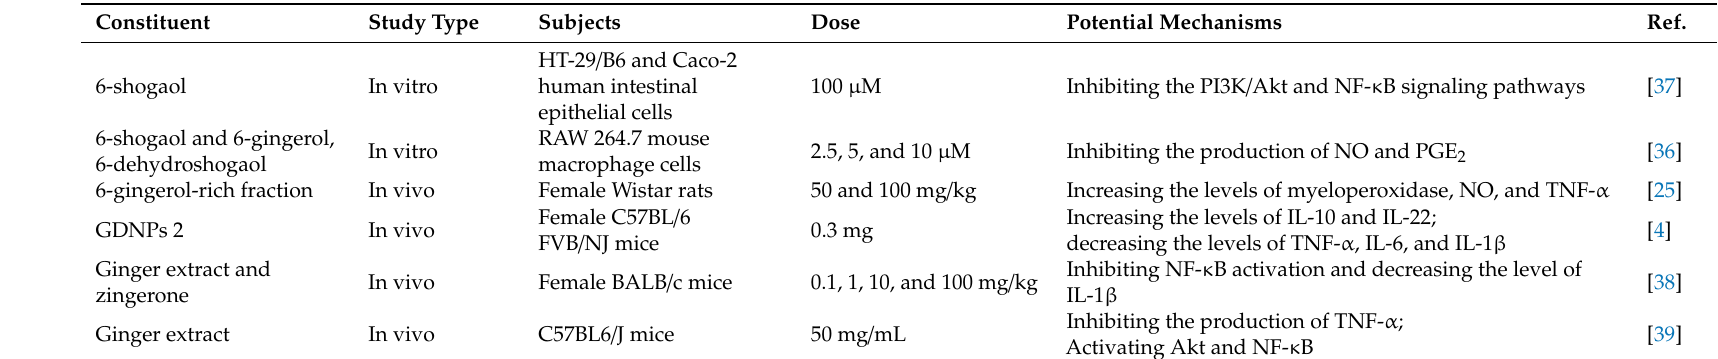
Table 2. Anti-inflammatory activity and potential mechanisms of